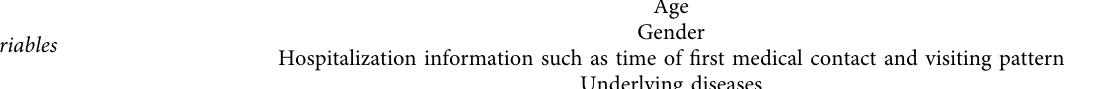
Table 1: Variables collected from the electronic health records of Peking University Tird Hospital.